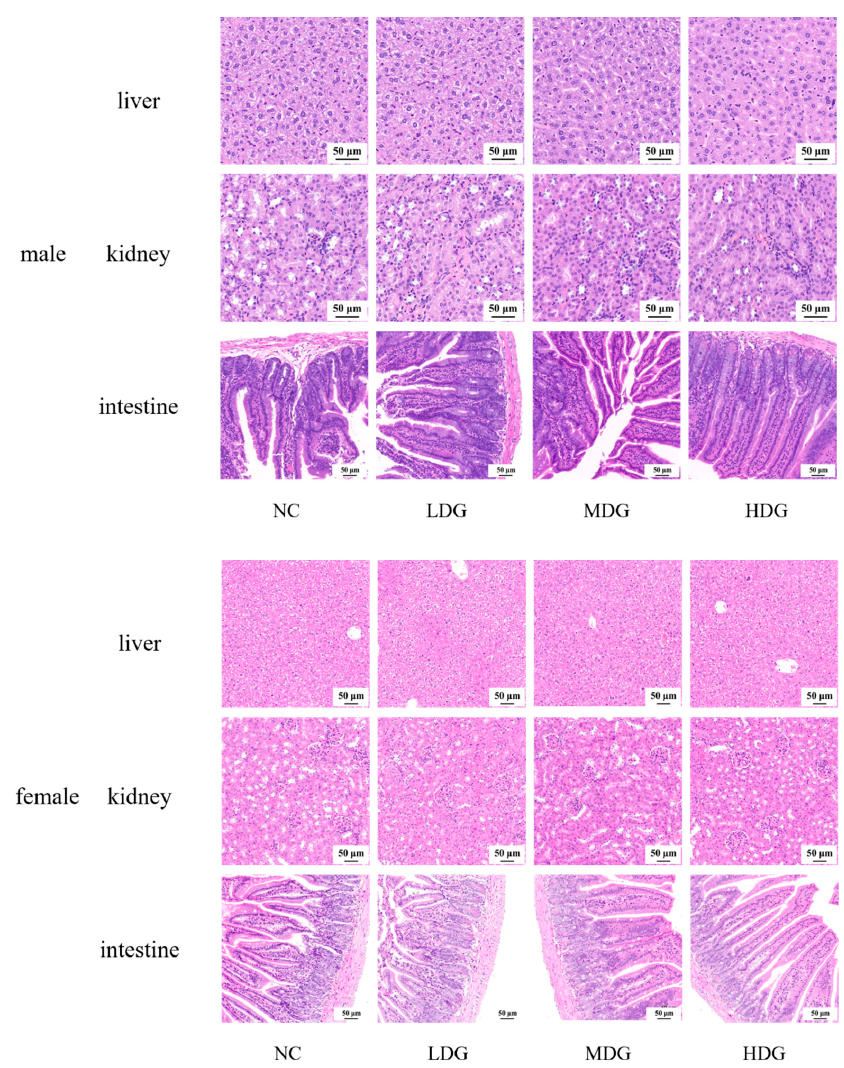
Figure 4. Tissue samples were collected for HE staining and pathological analysis was conducted. Liver, kidney, and intestine sections in mice with different concentrations of strain for 28-days repeated toxicity. The NC was fed with the saline and LDG, MDG, and HDG were fed with the saline containing 10 8 , 10 9 , and 10 10 CFU/mL of isolate, respectively. (×200). Table 4. Hematological parameters and serum biochemistry in mice for 28-day repeated toxicity.